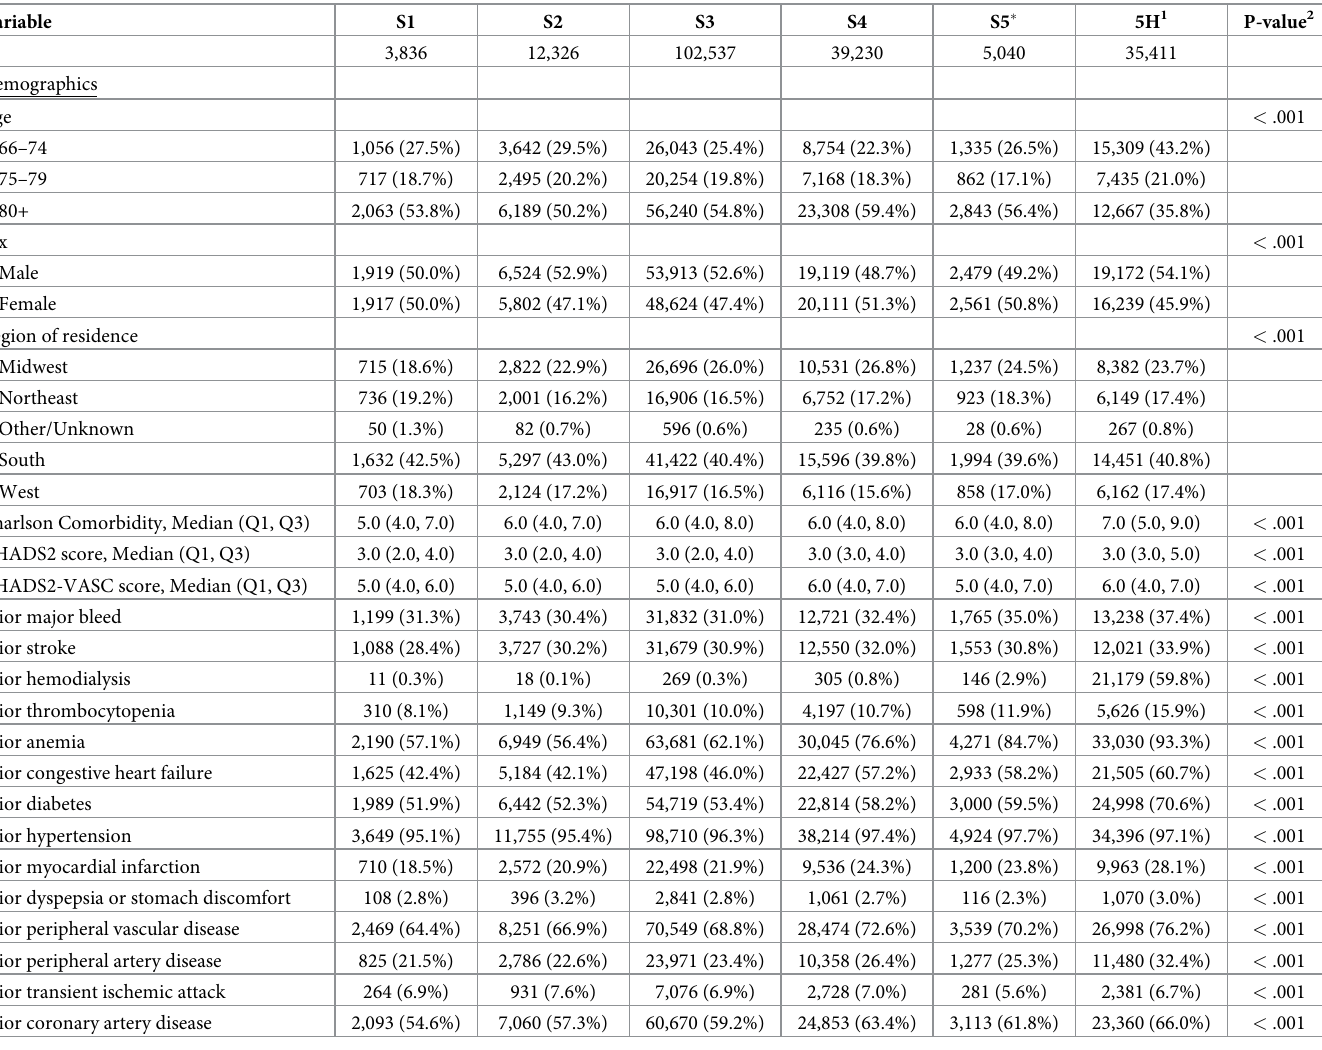
Table 1. Baseline characteristics of patients stratified by CKD Stage at NVAF diagnosis (N =